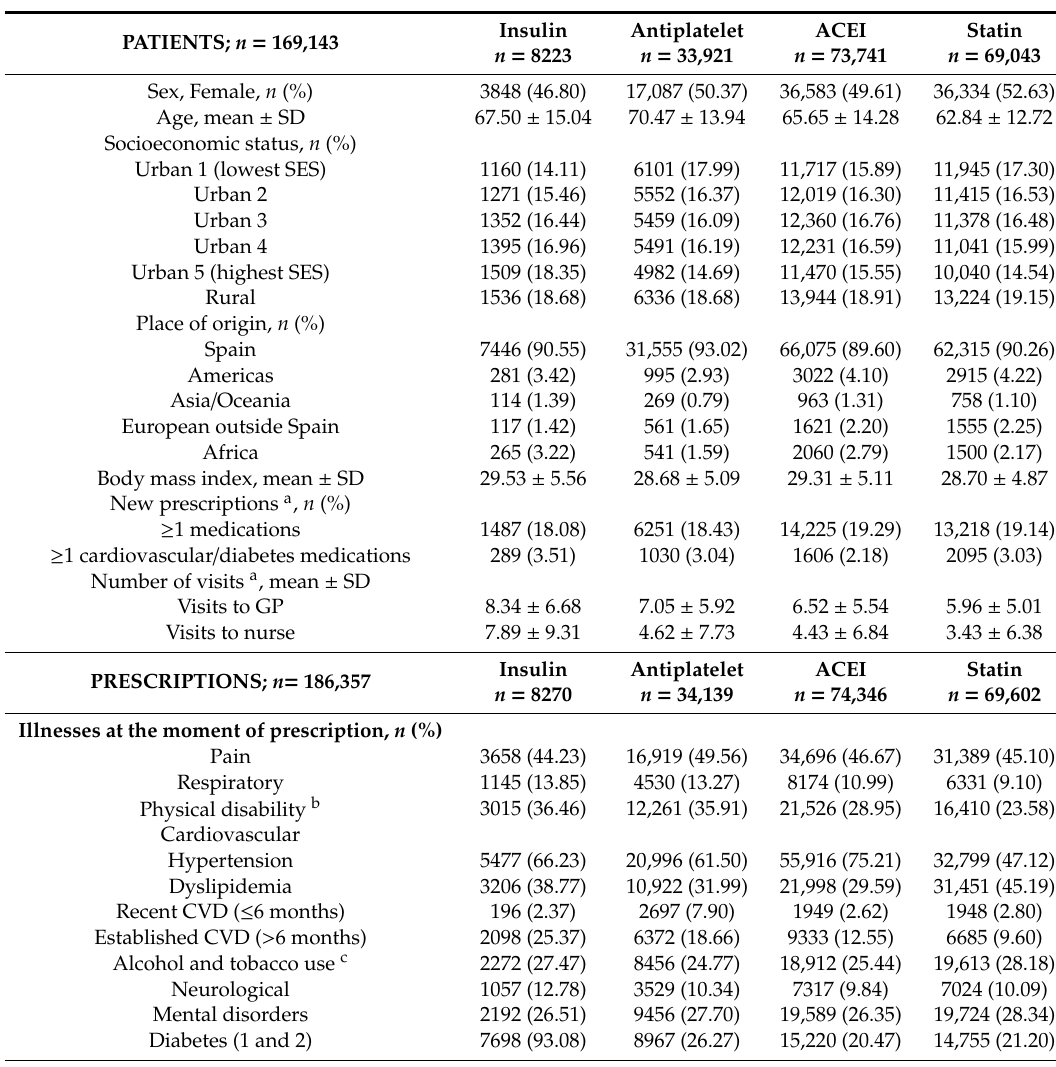
Table 1. Sociodemographic characteristics of the